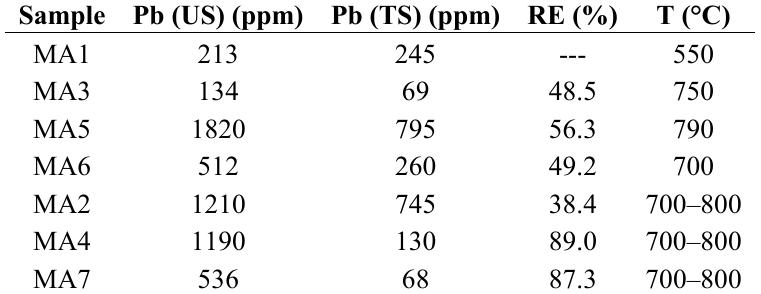
Table 6. Results of lead removal by solar thermal desorption with the rotary kiln. US, untreated sample; TS, treated sample; RE, removal efficiency; T, mean temperature reached.